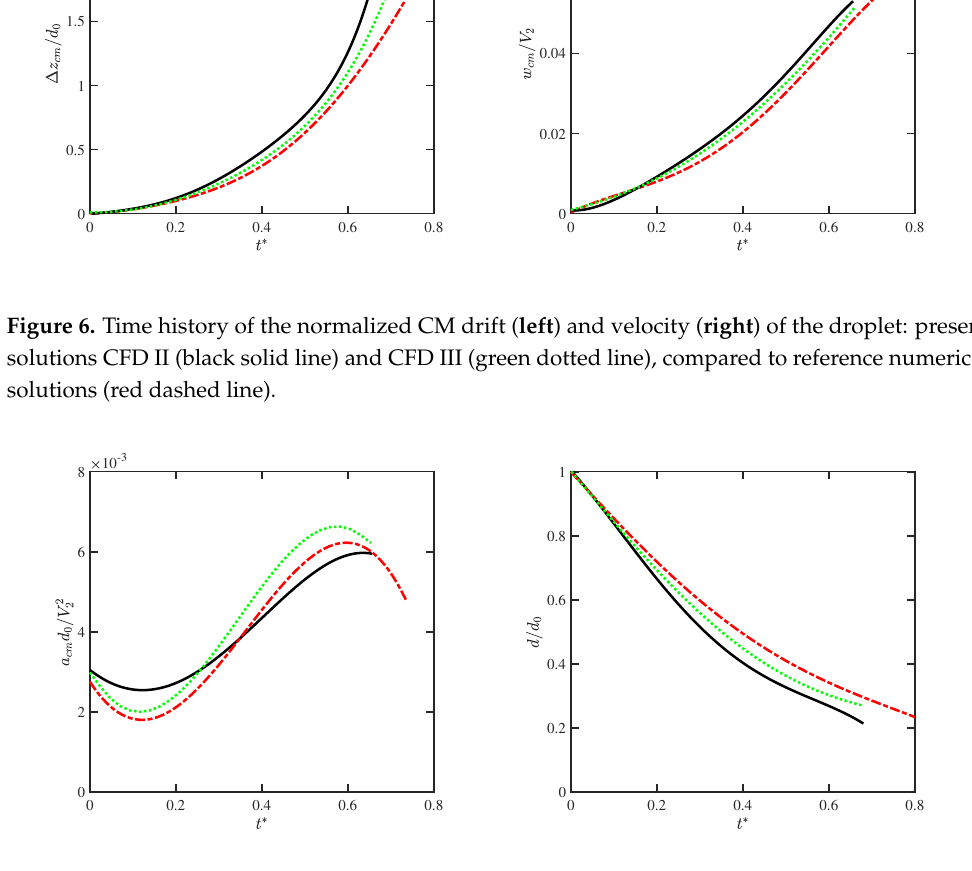
Figure 7. Time history of the normalized CM acceleration ( left ) and axial width ( right ) of the droplet: present solutions CFD II (black solid line) and CFD III (green dotted line), compared to reference numerical solutions (red dashed